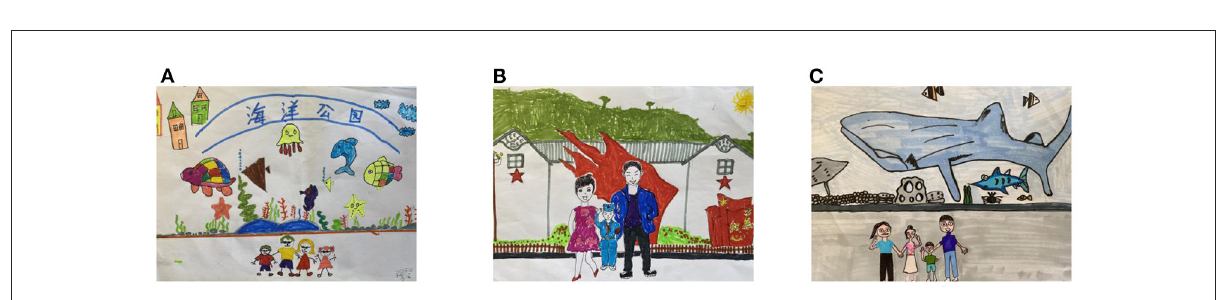
FIGURE2 Parental companionship in children’s drawings (A) Lower grader (1-08Y); (B) Middle grader (3-15Y); (C) Upper grader